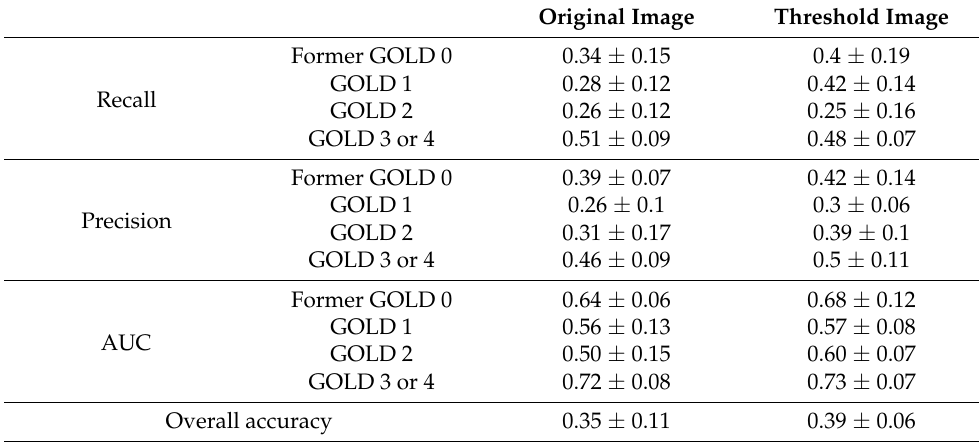
Table 3. Recall, precisions, AUC, and overall accuracy for four-class